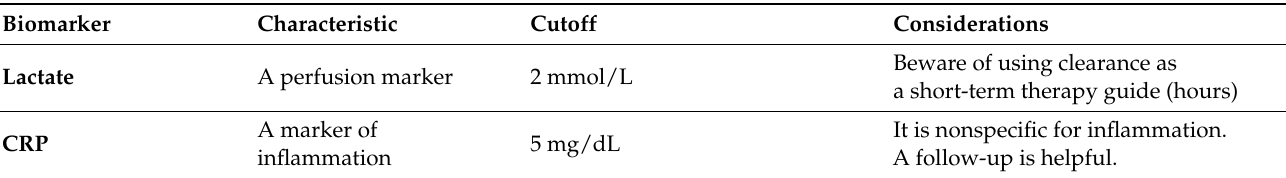
Table 1. Biomarkers: main characteristics and cutoff